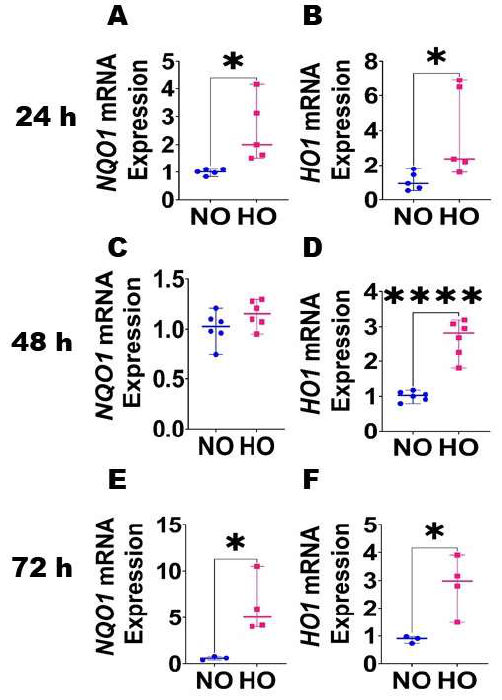
Figure 3. Effects of HO exposure on the expression of antioxidant enzymes in HDLECs. RNA was extracted at the indicated time points from cells grown on six-well plates to 60–70% confluence and exposed to NO (21% O 2 and 5% CO 2 ) or HO (70% O 2 and 5% CO 2 ) for up to 72 h. The RNA was later transcribed to cDNA and subjected to real-time RT-PCR analysis to quantify the mRNA levels of NQO1 ( A , C , E ) and HO1 ( B , D , F ) at 24 h ( A , B ), 48 h ( C , D ), and 72 h ( E , F ). Values represent the median with range ( n = 3–6/group). Significant differences between exposures are indicated by *, p < 0.05, ****, p < 0.0001 ( t -test).